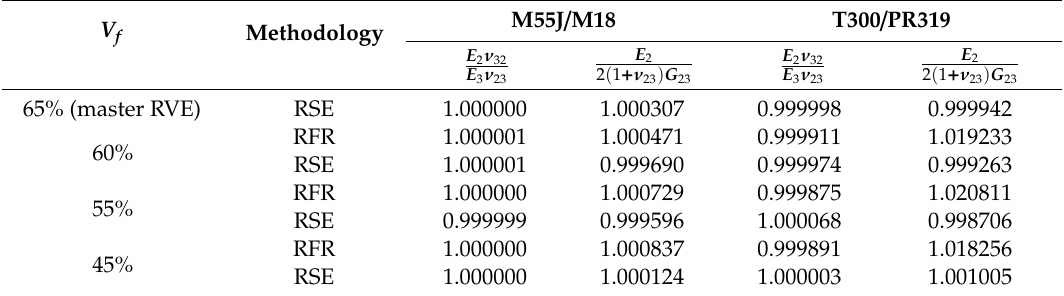
Table 6. Symmetry of the compliance matrix and anisotropic ratio of M55J / M18 and T300 / PR319 with noncircular